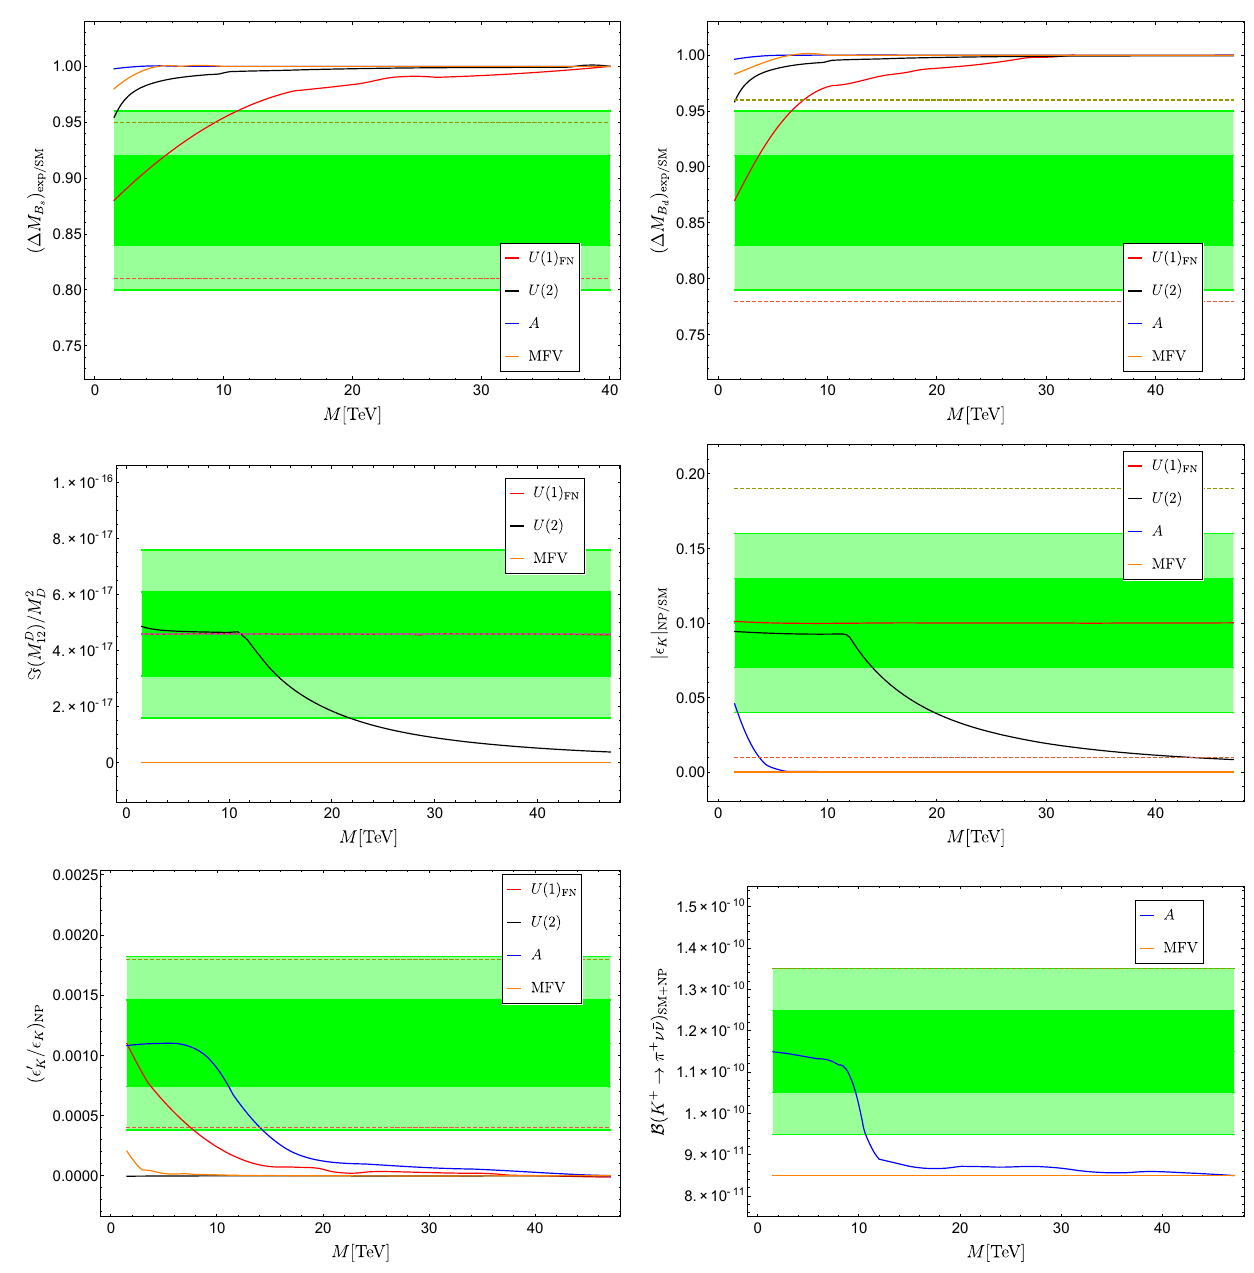
Fig. 1 Comparison of different flavour models, within the MSSM, in accommodating observables that could exhibit a 3 σ deviations with respect to the SM, as function of the overall soft-breaking scale M (see main text). The green bands denote the 1 σ and 2 σ regions around